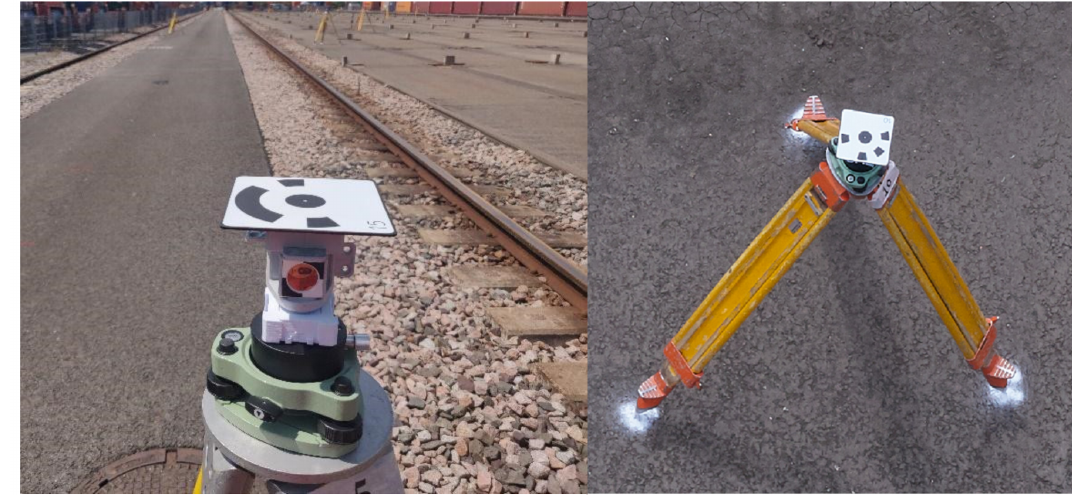
Figure 2. The structure of the marker with the prisms. Left side view: the centers of the prism and the marker are arranged collinearly; the distances are known. Right: marker in aerial view.